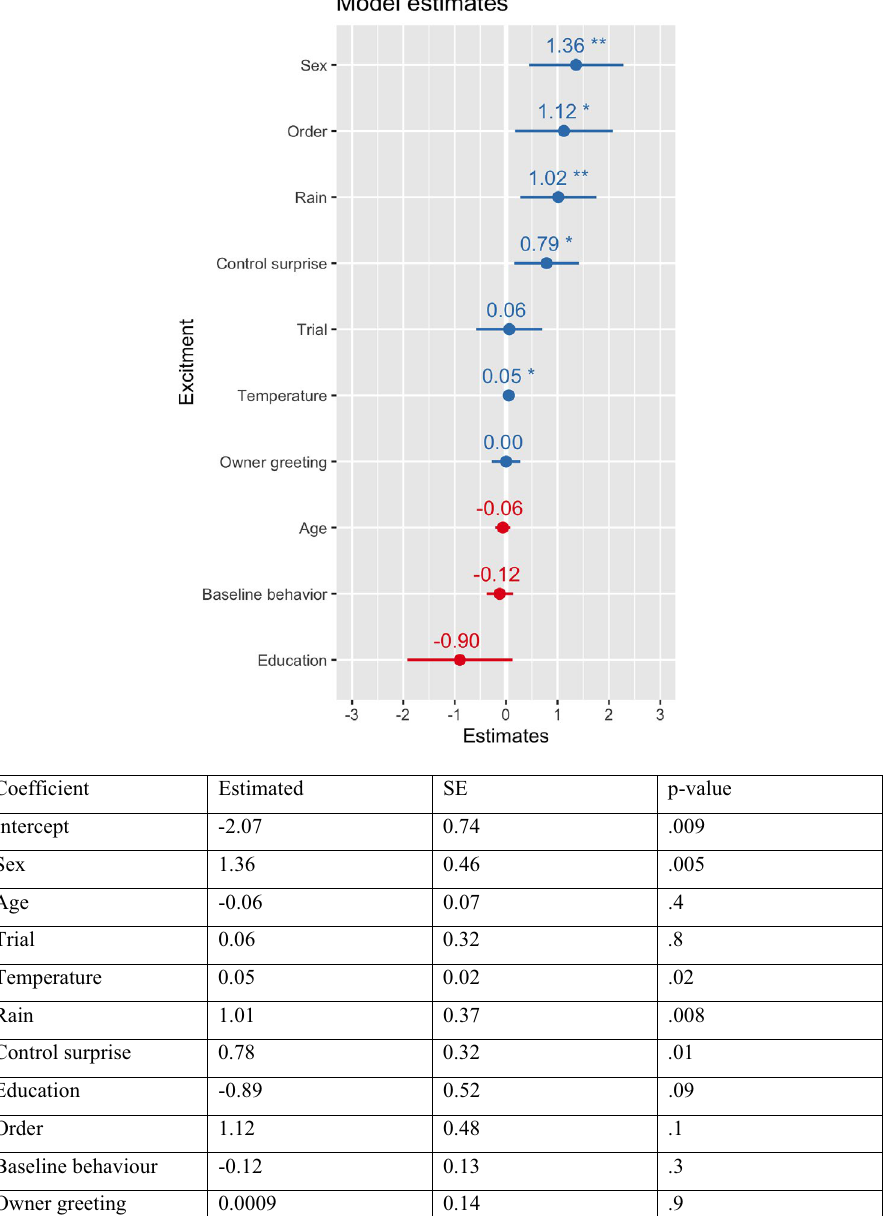
Figure 2. Estimated coefficients for the main model with behavioural excitement (B2) as response. Positive (blue) and negative (red) estimates are associated with increased and decreased excitement in the behavioural experiment. ** p < 0.01; * p <